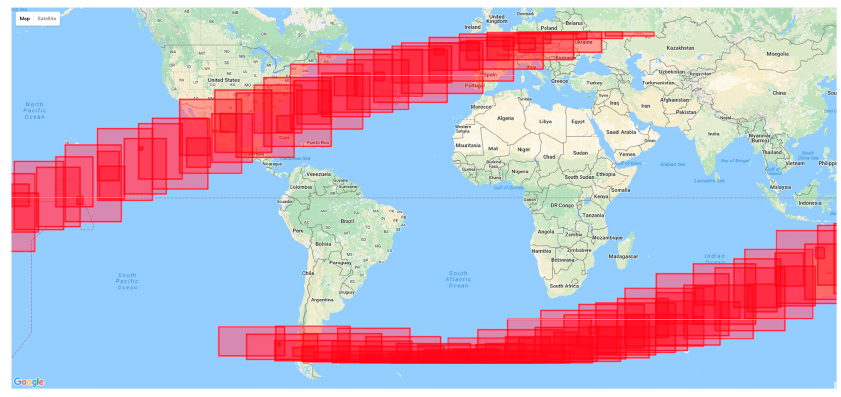
Figure 5. MIIC event prediction web interface, ISS versus Aqua, one month predicts for January 2015; twin = 10 min, vzmax = 180°, szmax = 75°.